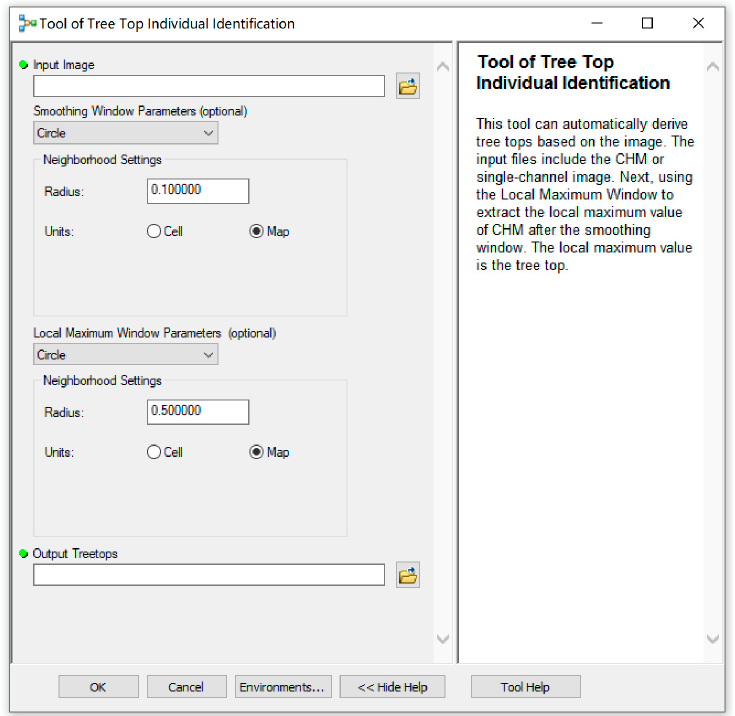
Figure A2. A visual modeling environment using the LM algorithm for individual tree detection.